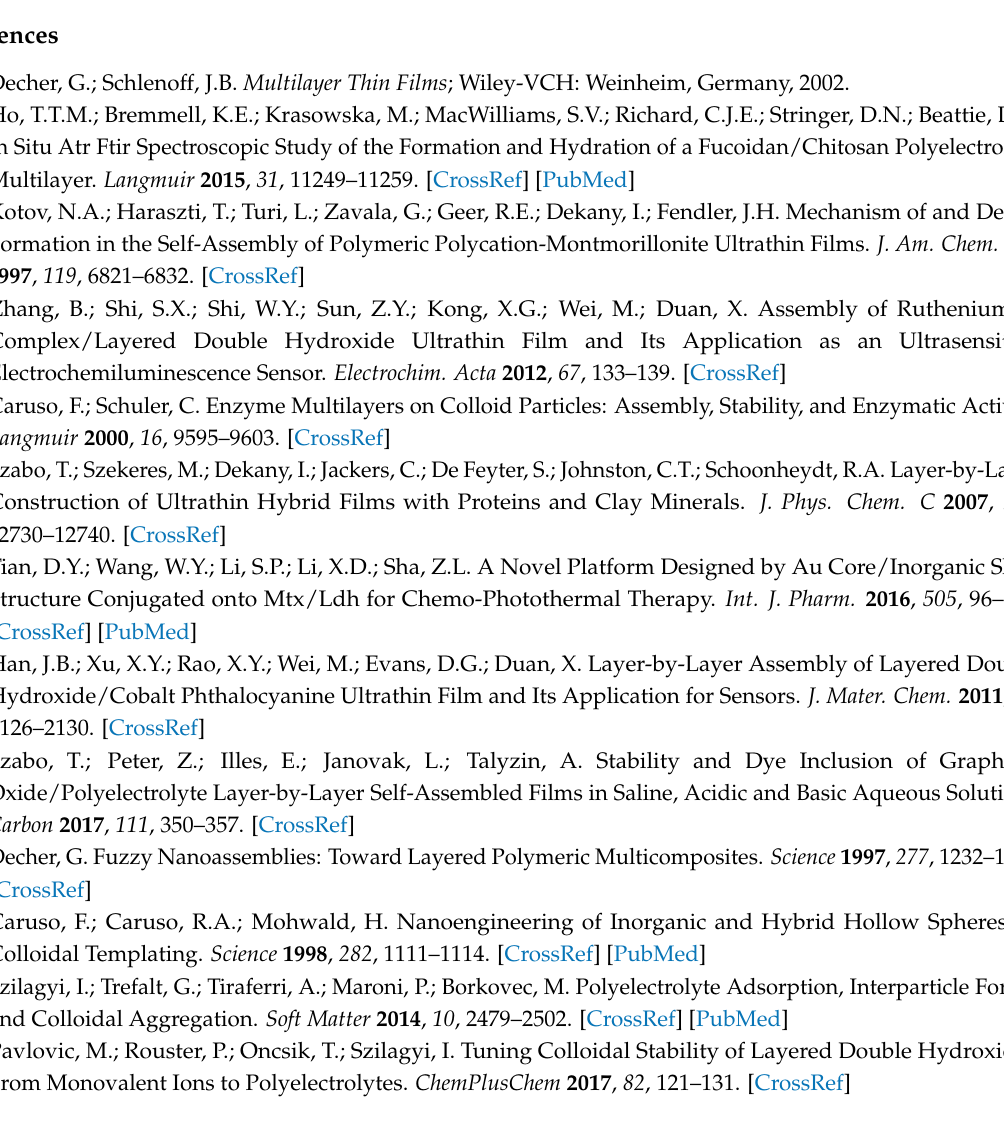
Figure S1: Electrophoretic mobility data of LDH in the pre sence of PSS measured at different ionic strengths; Figure S2: Electrophoretic mobility data of LDH-PSS in the presence of PDADMAC measured at different salt concentrations; Figure S3: Hydrodynamic radii of bare and polyelectrolyte-functionalized